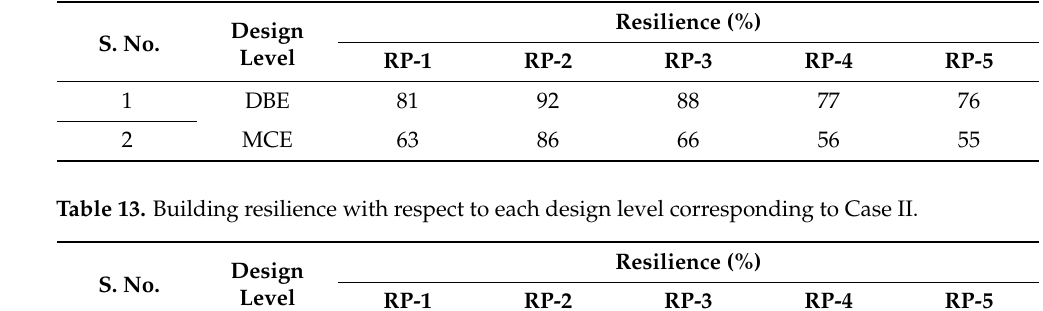
Table 12. Building resilience with respect to each design level corresponding to Case I. S. No.